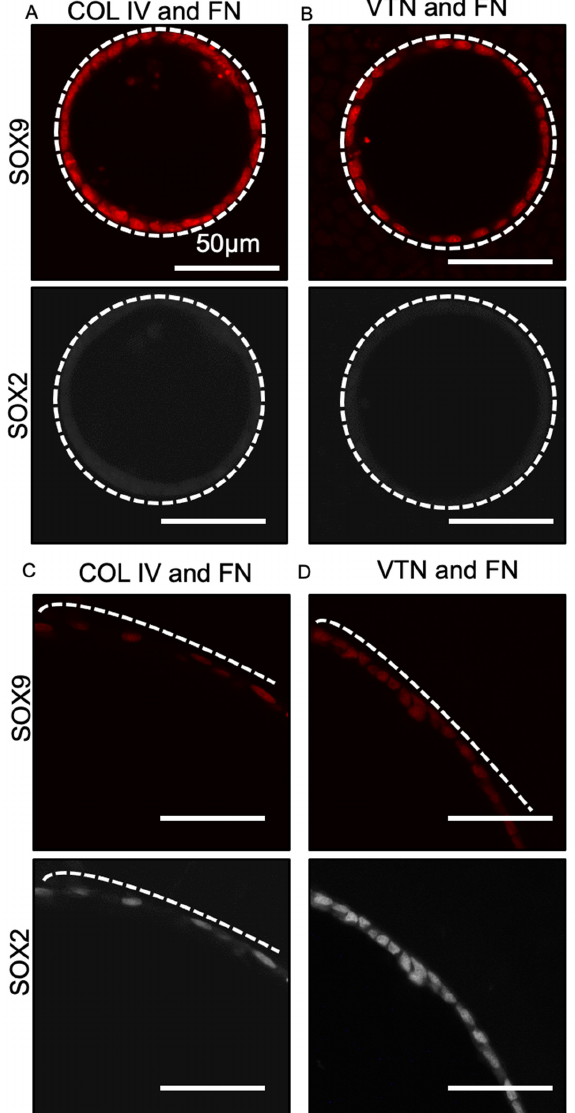
Figure 3. SOX2–SOX9 status of lung progenitors seeded in 100- and 400-micron tubes with different matrix coatings. Fluorescent micrographs of day 17 lung progenitors seeded for 8 days at 600,000 cells/cm 2 collagen IV and fibronectin ( A ) and vitronectin and fibronectin ( B ) show that in 100 µm tubes the cells are SOX9+, while the cells in 400 µm ( C , D ) remain SOX2 + SOX9 + . Bar, 50 µm; the dotted white line approximates the PDMS border; n = 3.